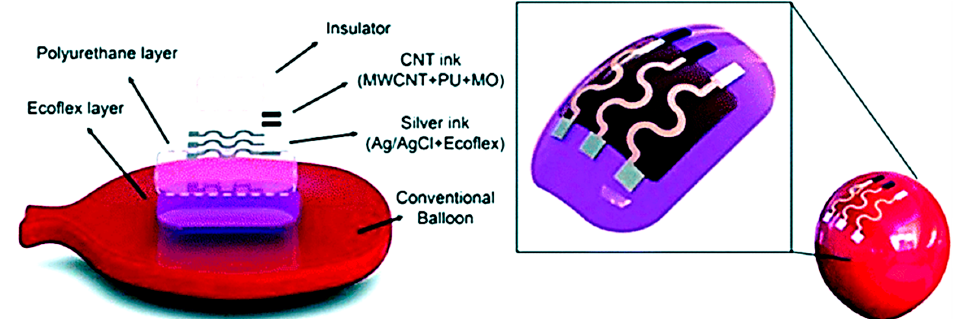
Figure 3. An example of wearable sensor demonstrated on a balloon which shows adaptability to curvilinear surfaces. The multiple layers consist of an Ecoflex layer (inner), polyurethane (intermediate), a printable sensor (Ag/AgCl with Ecoflex composite) and a flexible insulator layer (upper) (Adapted with the permission from Wiley Materials) [18].